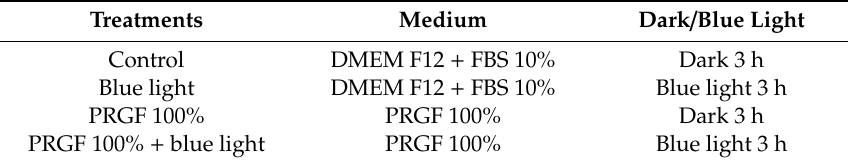
Table 2. Experimental groups for ex vivo model.